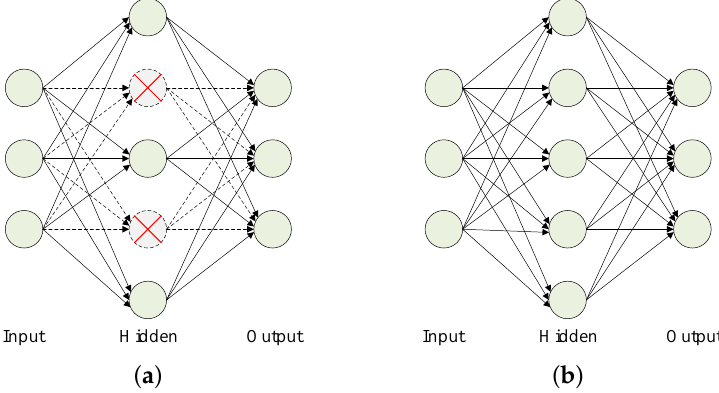
Figure 13. A basic neural network architecture ( a ) with and ( b ) without the dropout strategy.